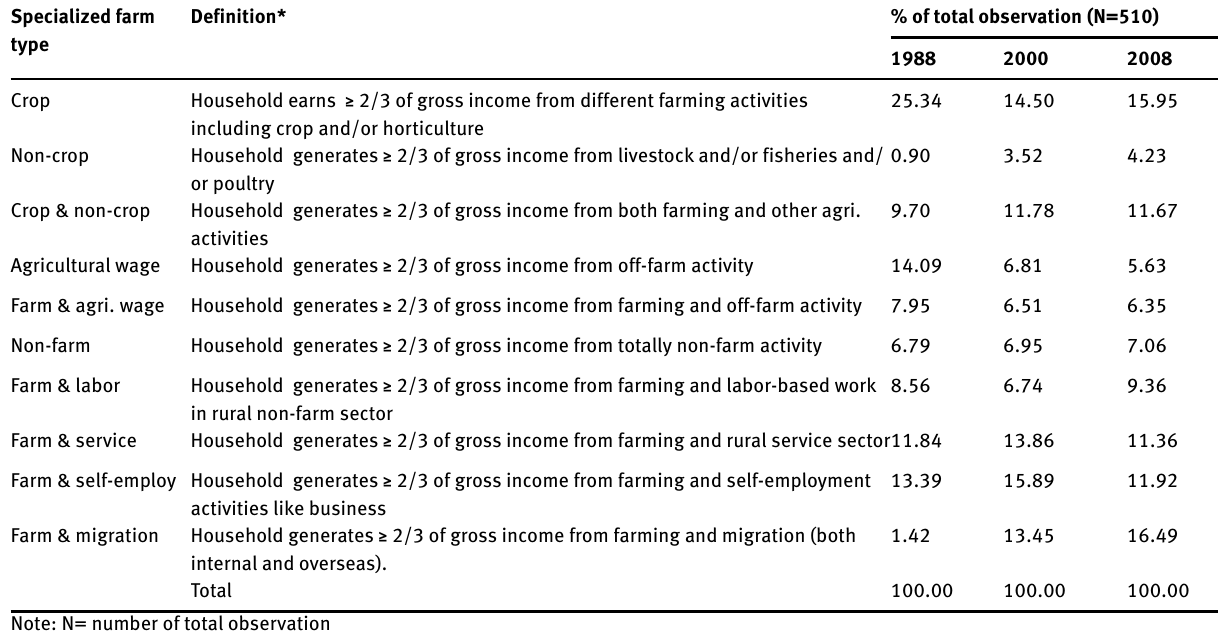
Table 1: Definitions and proportion of household participations in economic activities Specialized farm